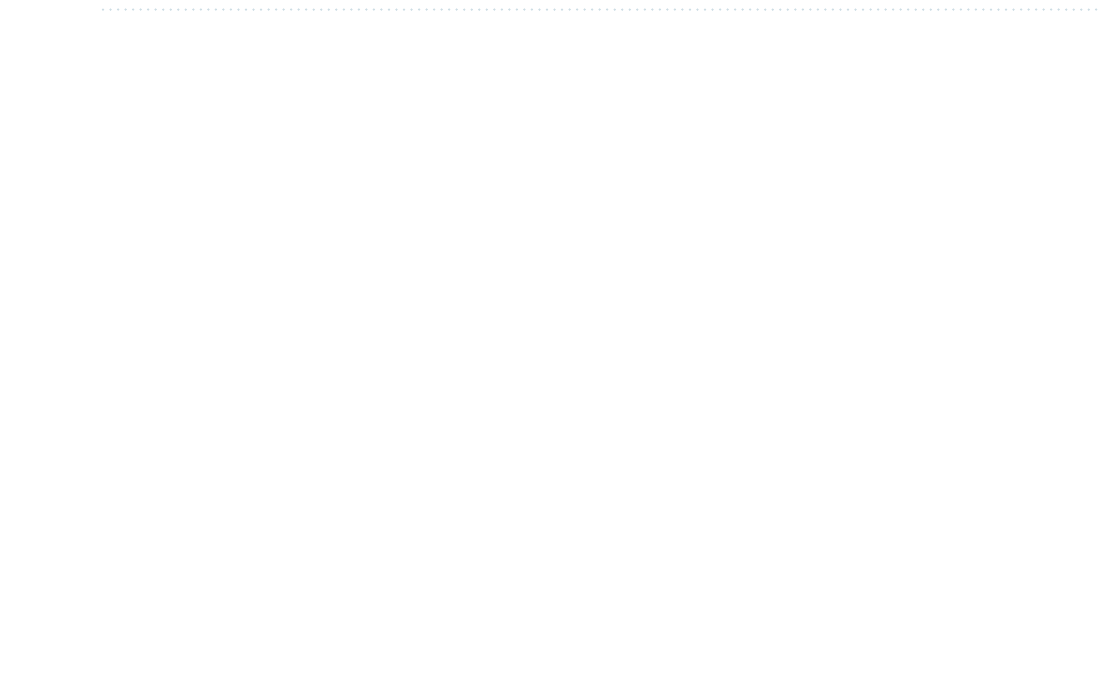
Figure 9. Behavior of streamlines against distinct values of ( a ) M = 0.5 , ( b ) M = 1 , ( c ) M =